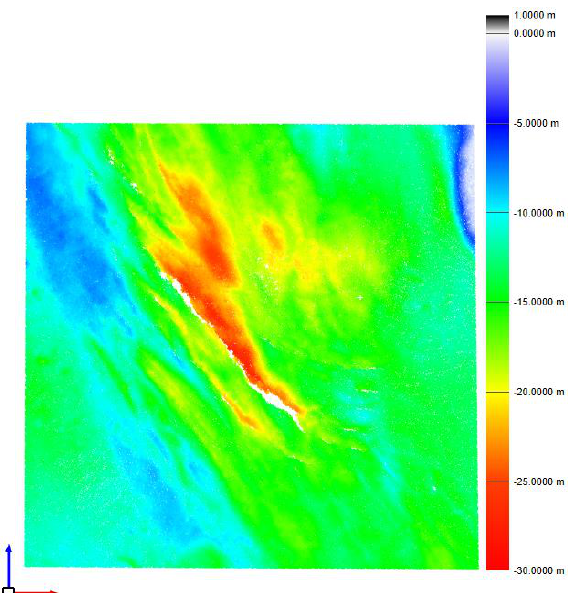
Figure 9. Height comparison map between 2014 DPC co- registered using CP2016 method and 2016 DPC: focus on Area3.